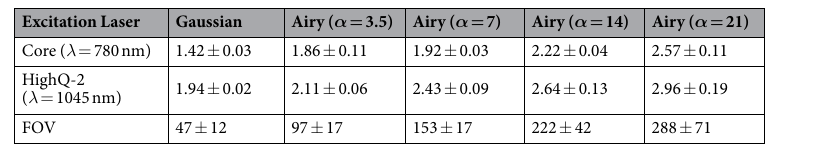
Table 1. Comparison of the experimentally determined axial resolution and FOV for each light sheet type in microns. The axial resolution is calculated as a mean FWHM of PSF as probed with 0.2 μ m diameter green and red fluorescent microspheres. The FOV is averaged over results obtained with both the Core and HighQ-2 laser. The uncertainties are given at 95% confidence level.